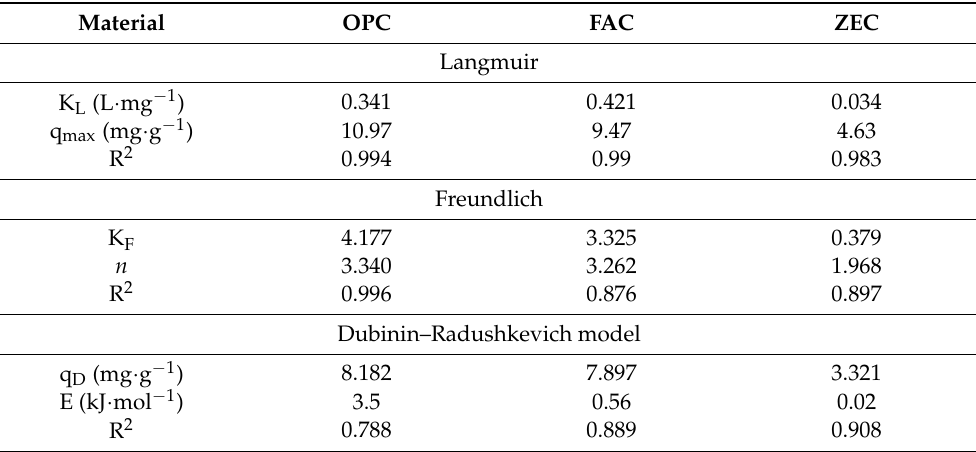
Figure 3. Adsorption isotherm of Cd by OPC, FAC, and ZEC pastes. Table 2. The parameters for adsorption of Cd in OPC, FAC, and ZEC obtained from various adsorp- tion